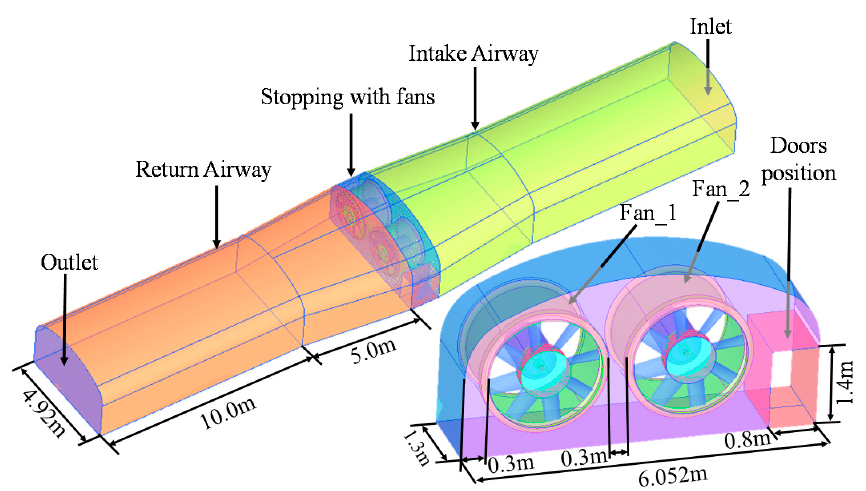
Figure 3. Arrangement diagram of the 50 m station.